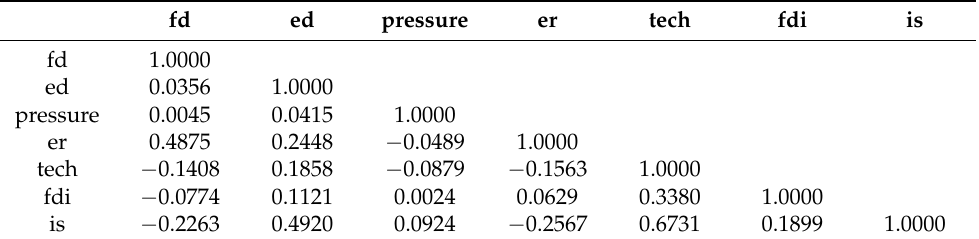
Table 2. Correlation coefficient matrix of the main explanatory variables.